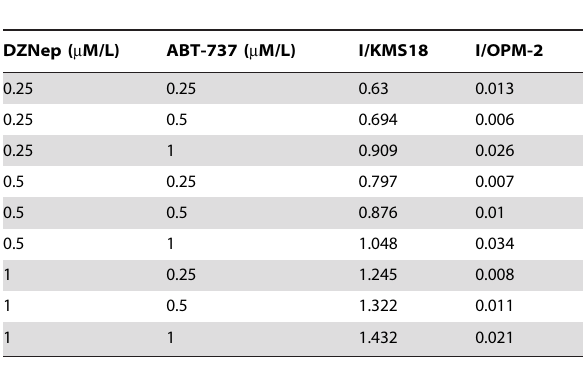
Table 1. The combination index (CI) for DZNep and ABT-737